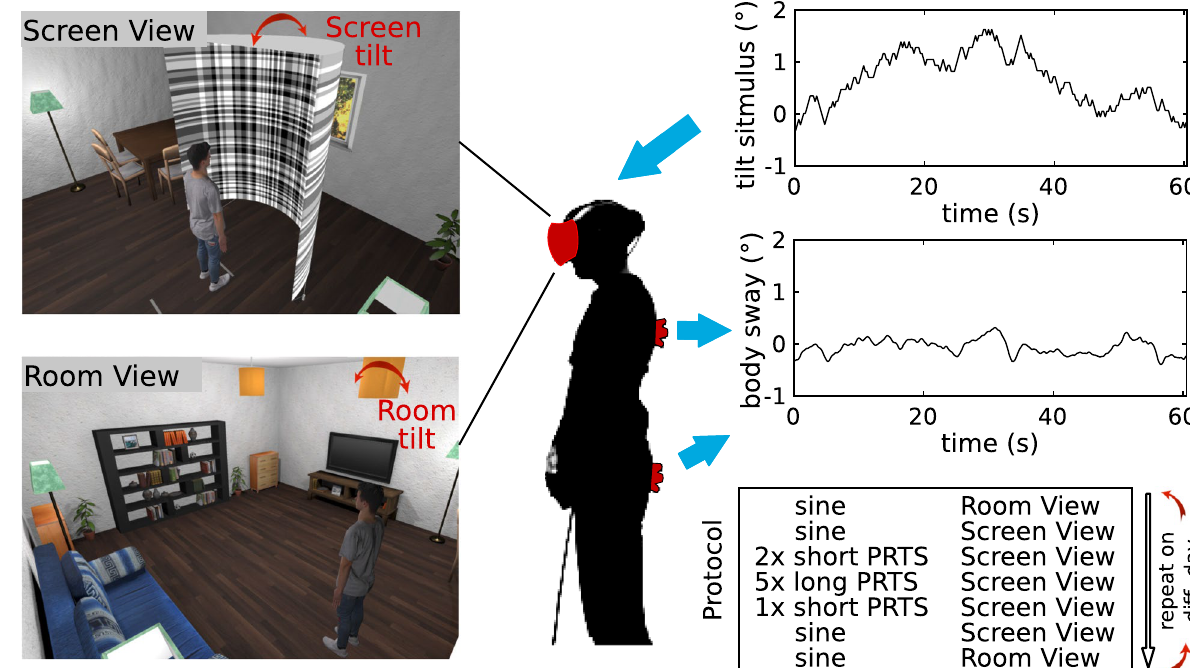
Figure 1. Virtual screen and room used during the experiments together with the hardware setup. The VR avatar indicates the perspective of a subject in the respective condition. Both images are screenshots of the custom made application created in Unity (Unity Technologies, San Francisco, USA). Head-mounted display used to display the virtual environment and the two VR motion tracker used for body sway recordings are shown in red. Top panel on the right shows an example of the long-PRTS stimulus sequence (60.5 s) that was repeated five consecutive times for each of the 5 amplitudes (peak-to-peak, pp0.5, pp1, pp2, pp4, pp8). Middle panel shows example whole body centre of mass sway derived from marker recordings. Bottom panel shows order of trials as applied during the